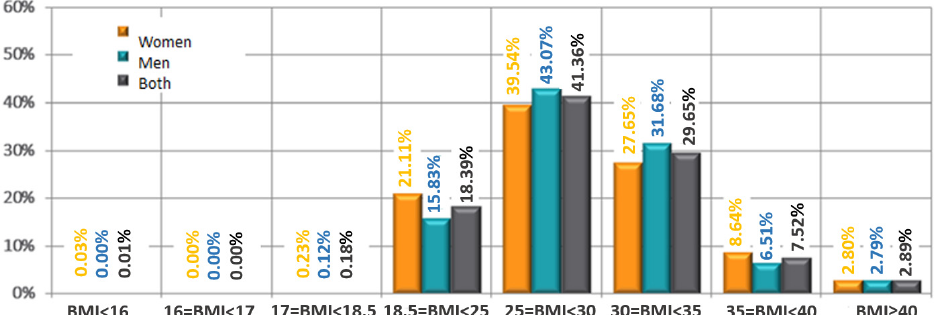
Figure 4. Distribution of BMI in studied population according to sex.